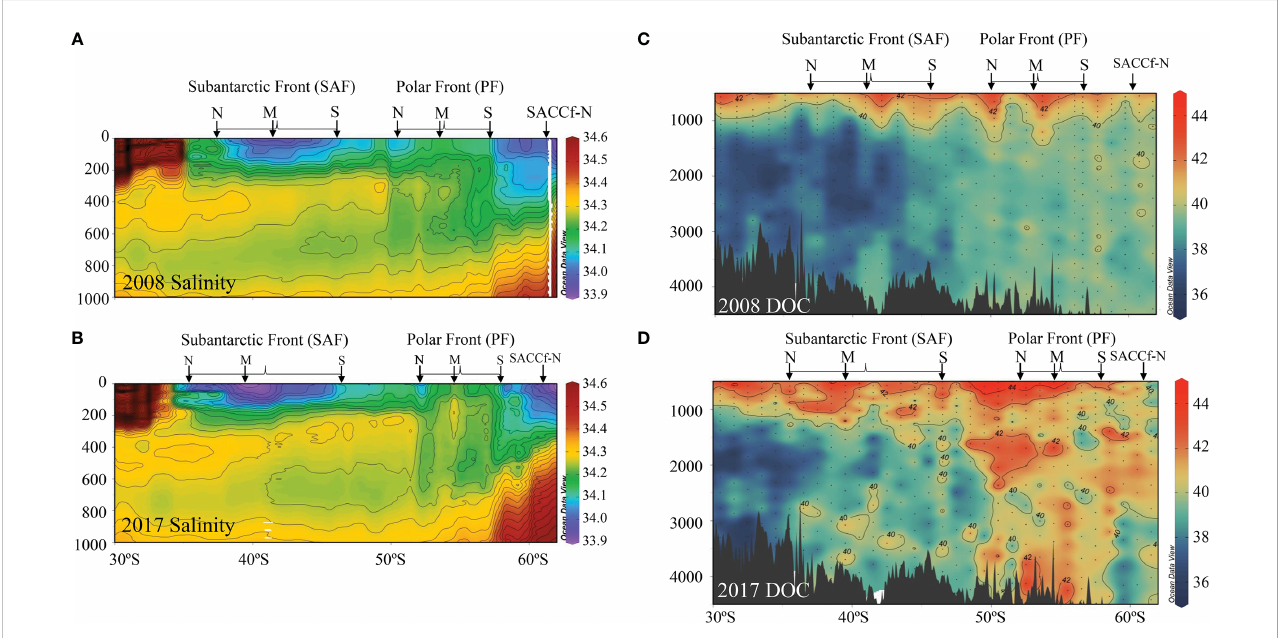
FIGURE 2 Upper ocean salinity distributions in (A) January 2008 and (B) January 2017 at 100°W ± 5° between 30-62°S that identify the latitudes of the north (N), mid (M), and southern (S) branches of the Subantarctic Front (SAF) and the Polar Front (PF). The location of the northern branch of the Southern Antarctic Circumpolar Current Front is also identi fi ed. Pro fi les were obtained from 265 and 665 Argo fl oat pro fi les, respectively (Argo, 2021). Contours for isohalines are in 0.025 increments. DOC concentrations [µmol C kg -1 ] in (C) January 2008 and (D) January 2017 along transect P18.